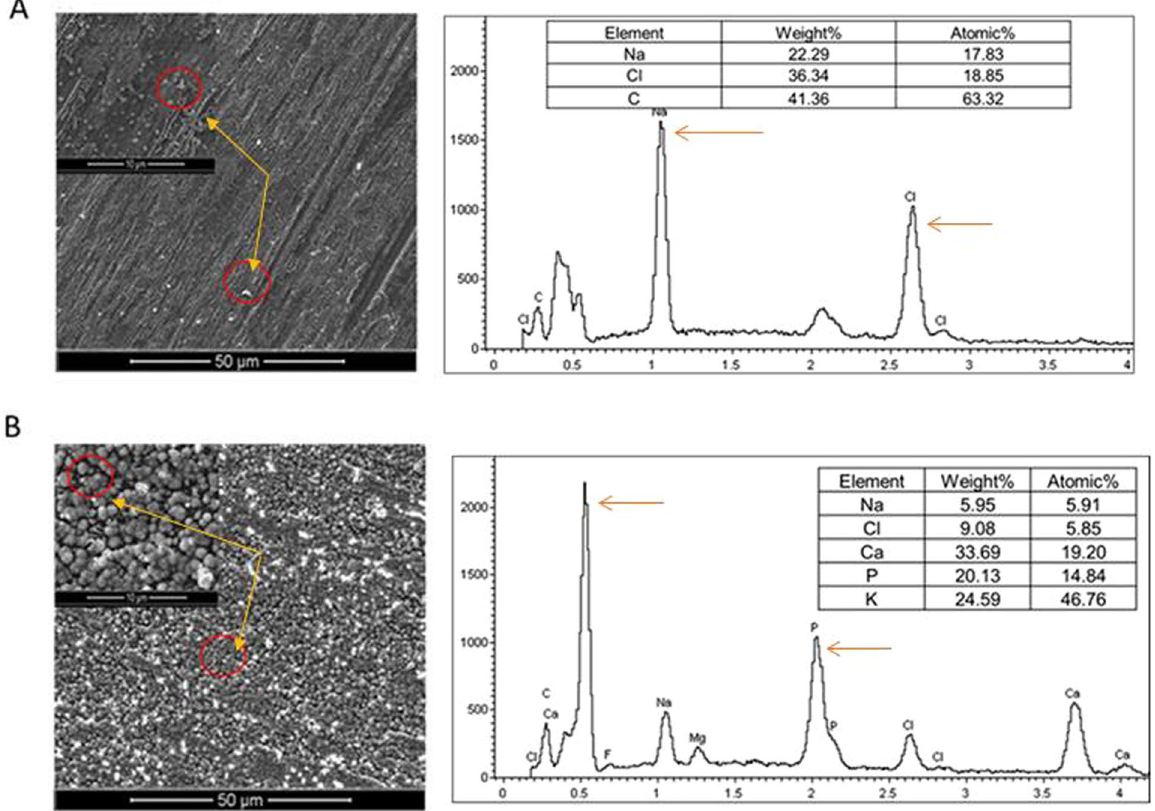
Fig. 2 FESEM and EDX profiles of apatite crystal formation on Ti alloy and TNA surface at 28-day immersion period in SBF. A apatite formation on TNA nanosurface with EDX profiles B apatite formation on Ti alloy without nanosurface with EDX profiles. The image was captured under